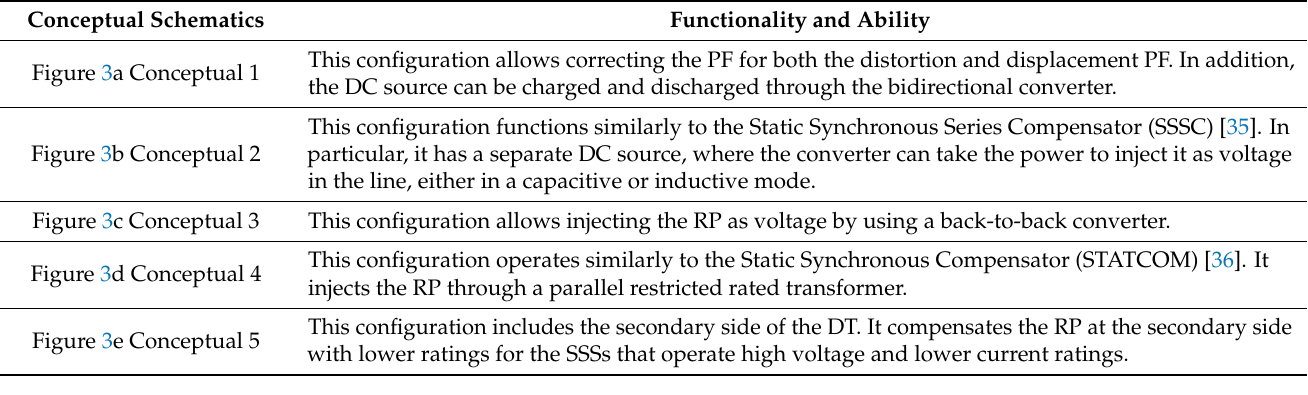
Table 1. Different schemes and their functionalities.